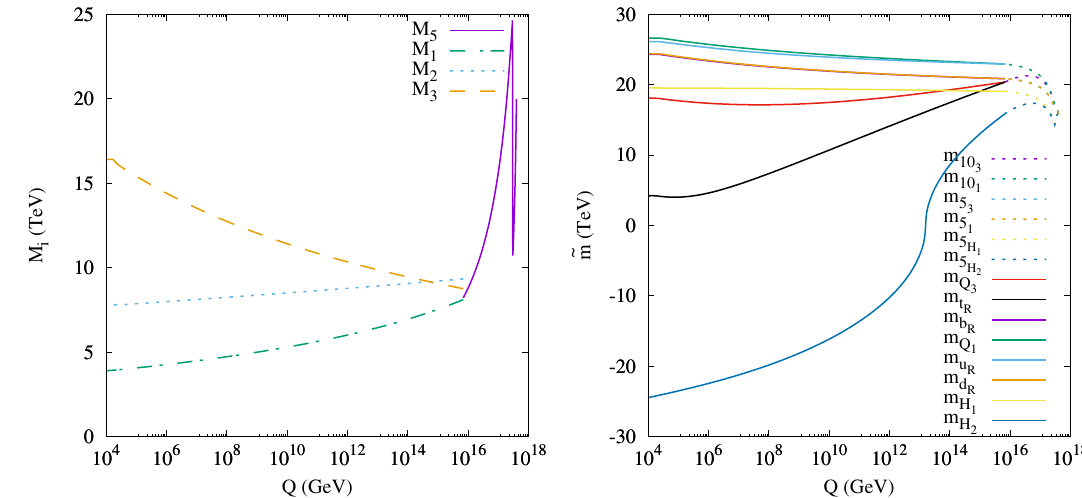
Fig. 2 Left panel: renormalization effects on the SU(5) gaugino mass M 5 , exhibiting its sharp decrease as μ → M X from above, and the subsequent evolution of the SM gaugino masses M 1 , 2 , 3 at lower scales, following threshold corrections at the GUT scale. Right panel: corre-